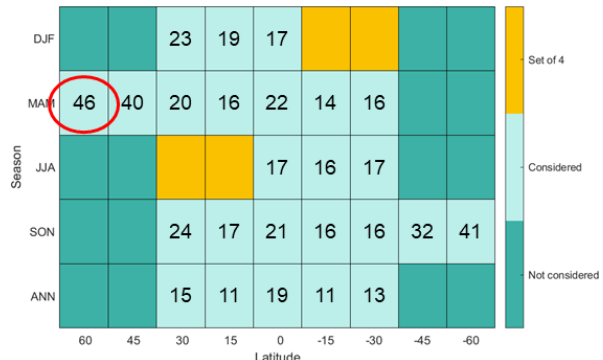
Figure 4. Angles (in degrees) between each unselected injection choice and a set of four injection choices (in orange): summer in- jection at 30, 15 ◦ N, 15, and 30 ◦ S. The x axis is the injection lati- tude and the y axis is the injection season. The maximum angle is 46 ◦ (highlighted by a red circle), formed between spring injection at 60 ◦ N and this set of